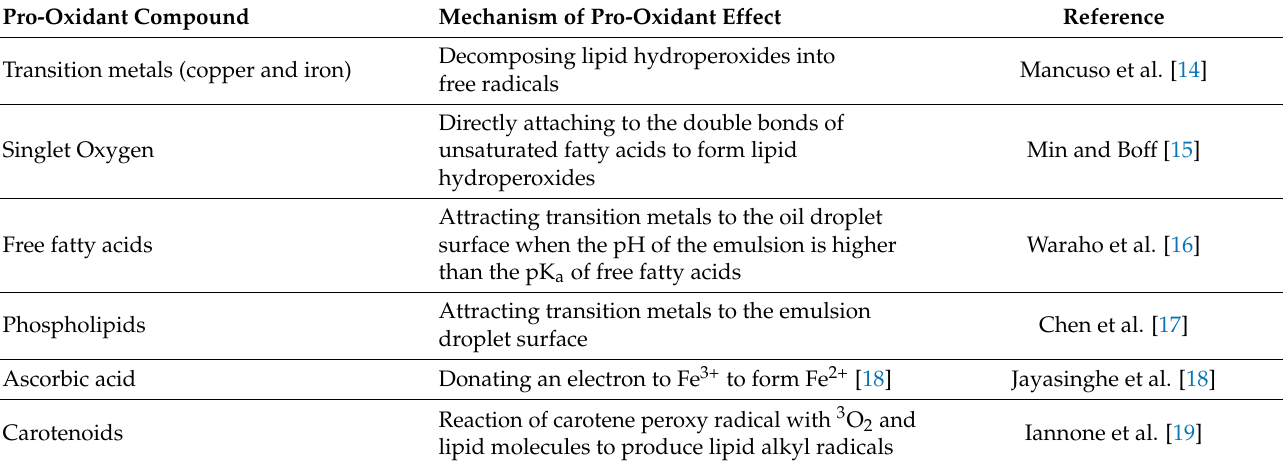
Table 1. Pro-oxidant compounds in bulk oil and oil-in-water